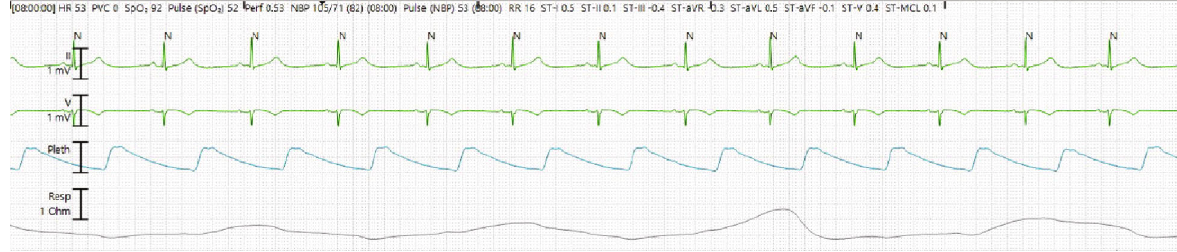
Figure 3: Telemetry strips showing bradycardia after the initiation of RDV (day two).